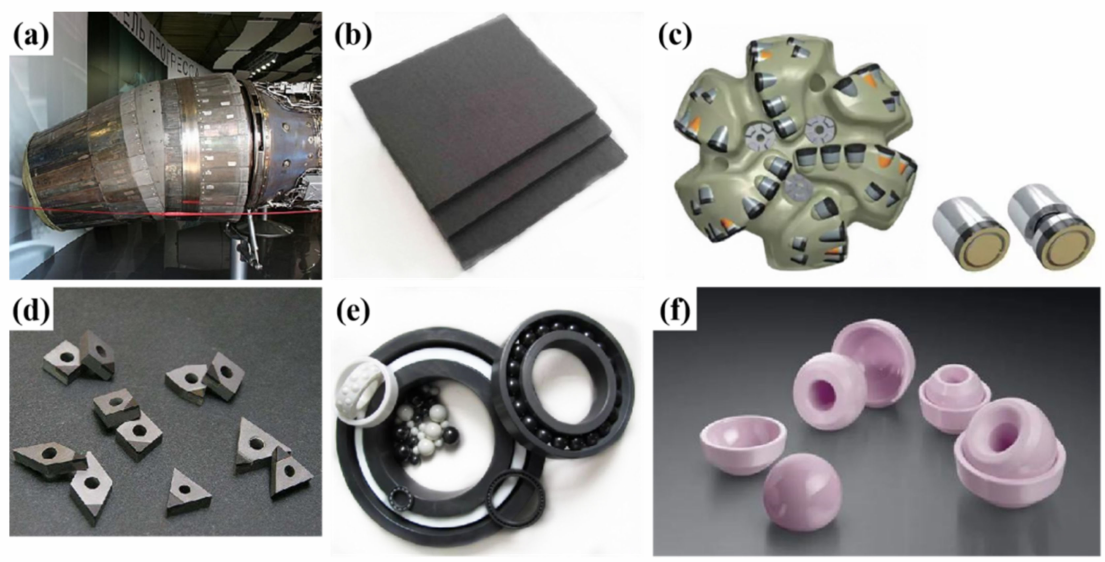
Figure 2. The industrial application prospect of typical TiC Composites: ( a ) Thermal protective material for the tail nozzle of an aeroengine. ( b ) New armor composite. ( c ) Related parts of an oil drilling bit. ( d ) High-speed cutting tool. ( e ) High-temperature-resistant ceramic bearing. ( f ). Artificial hip replacement